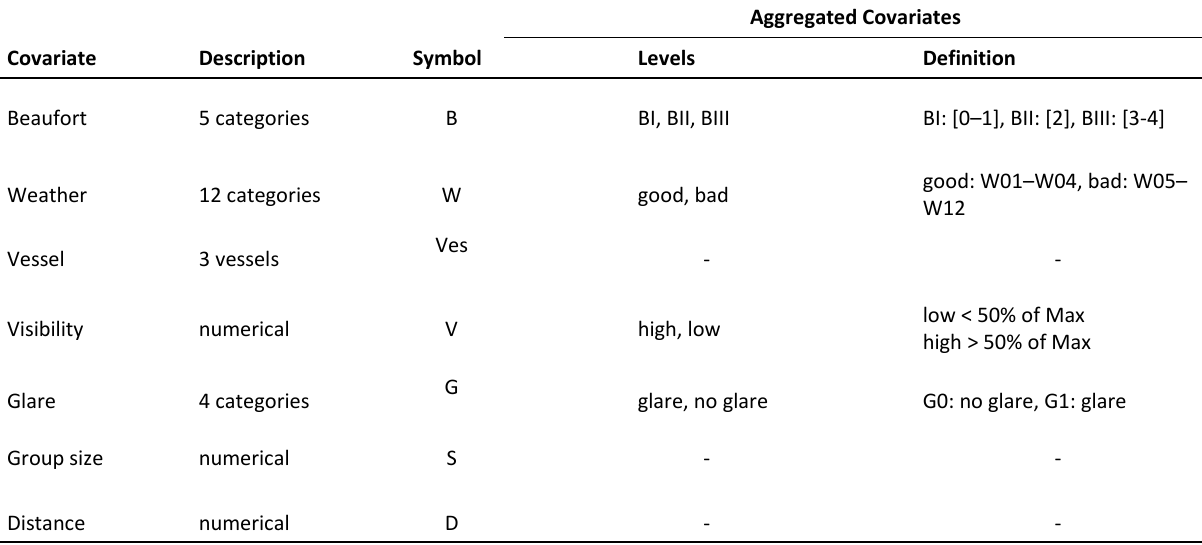
Table 1. Descriptions of covariates included to improve model fit. Some covariates were aggregated into levels for